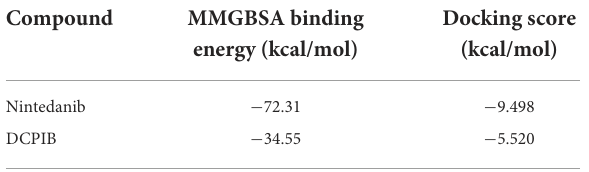
TABLE 1 Docking result of DCPIB and VEGFR2.